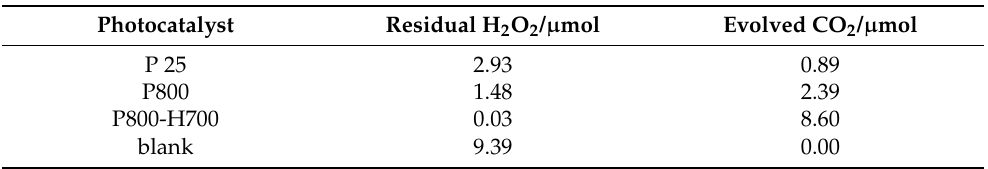
Table 2. Photocatalytic reaction in 1 vol% CH 3 COOH aqueous solution with 9 µ mol H 2 O 2 after violet light irradiation for 20